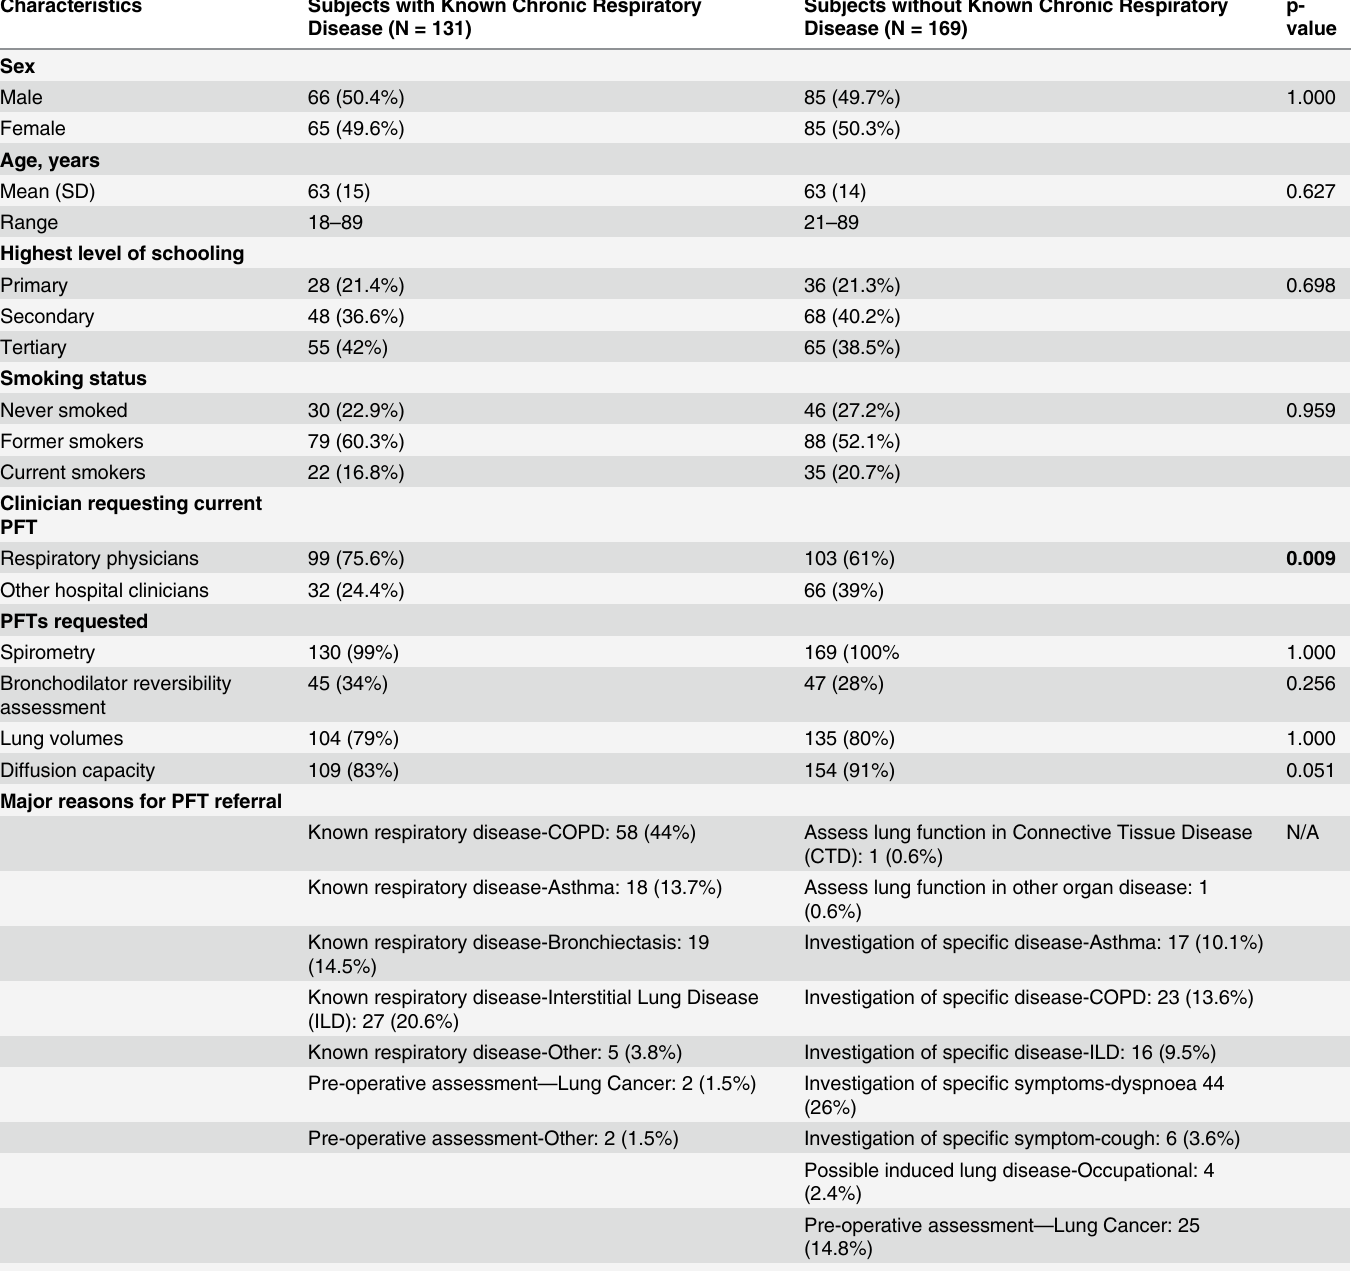
Table 1. Characteristics of